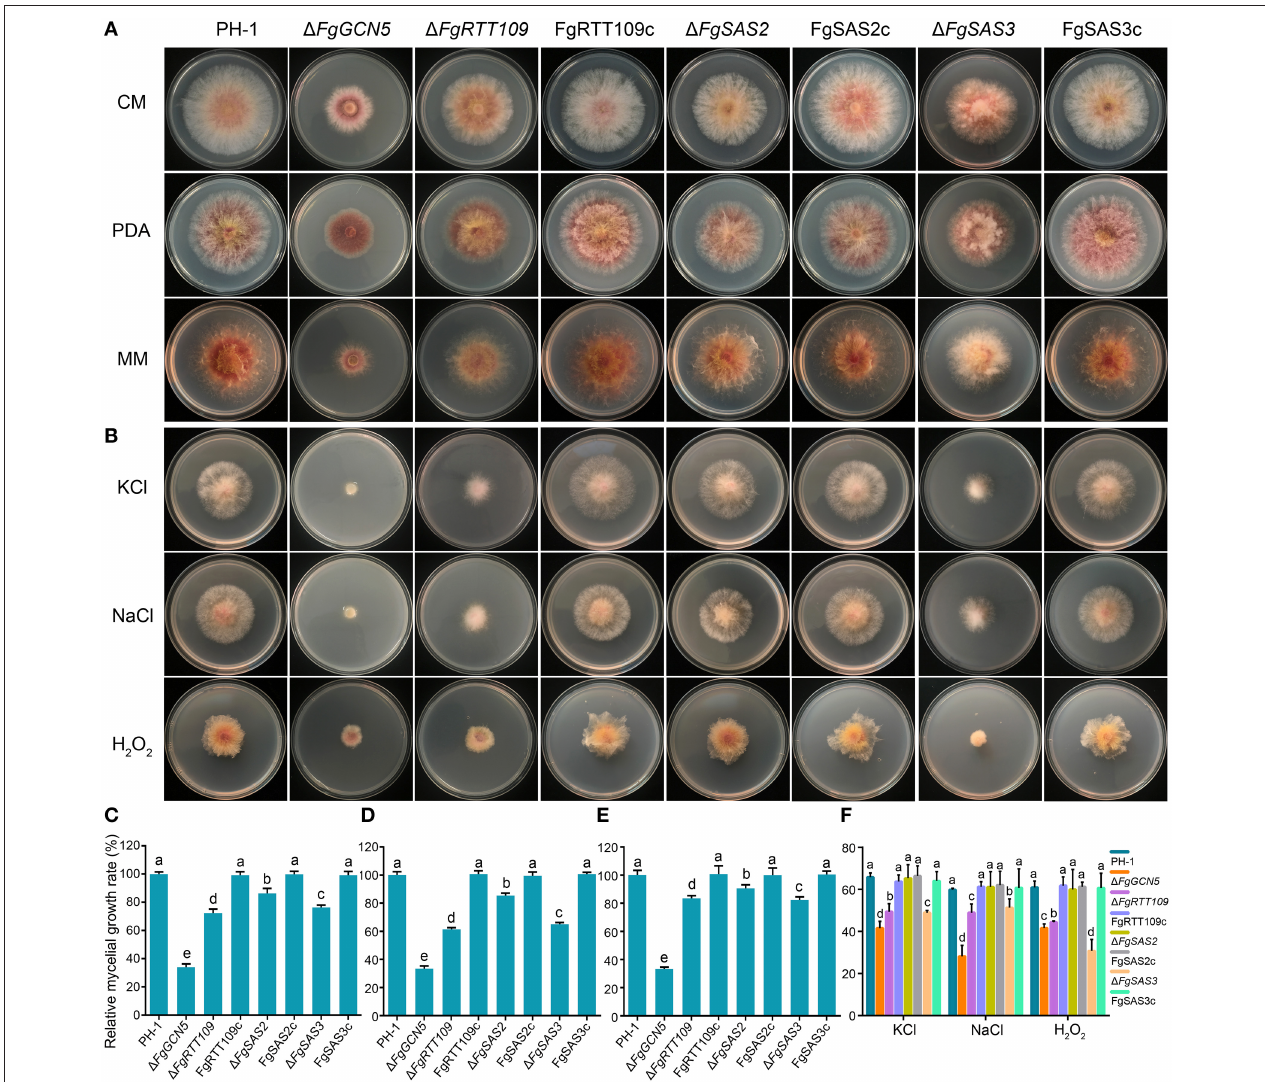
FIGURE 2 | Impacts of four HATs deletion strains on F. graminearum mycelial growth and their sensitivity to osmotic and oxidative stress. (A) The wild-type PH-1, deletion mutants ( 1 FgGCN5 , 1 FgRTT109 , 1 FgSAS2, and 1 FgSAS3 ) and the complemented strains (FgRTT109c, FgSAS2c, and FgSAS3c) were grown on PDA, CM, and MM at 25 ◦ C. (B) Sensitivity of each strain to osmotic stress and oxidative stress. Comparisons were made on MM amended with 1M NaCl or 1.2M KCl or 0.069% H 2 O 2 . (C,D,E) Relative mycelial growth rate was determined after incubation for 3 days on PDA, CM, and MM. Bars denote standard errors from five repeated experiments. Values on the bars followed by the same letter are not significantly different at P = 0.05. (F) Mycelial growth inhibition was examined after each strain was incubated for 3 days on MM amended with 1M NaCl or 1.2M KCl or 0.069% H 2 O 2 . Bars denote standard errors from five repeated experiments. Values on the bars followed by the same letter are not significantly different at P =